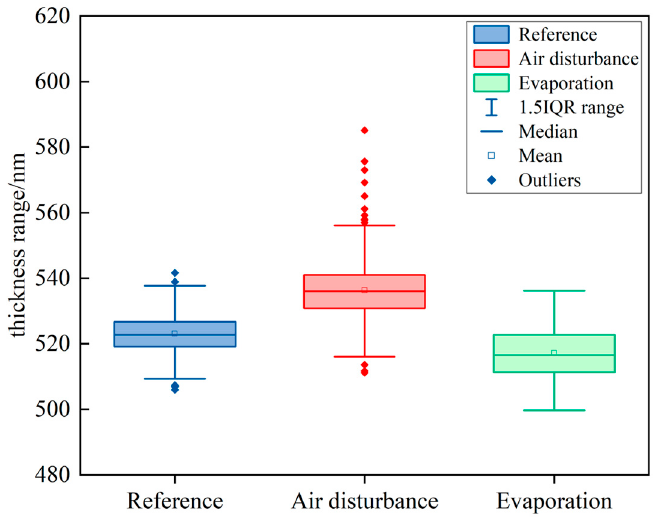
Figure 8. Statistical analysis results of film thickness data of the reference group (in blue), the airflow disturbance group (in red), and the evaporation group (in green). The thickness test data in each group of experiments is about 550.